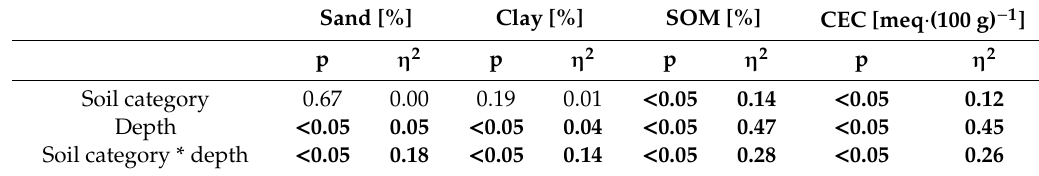
Table 6. Significance (p) and e ff ect size ( η 2 ), testing depth- and soil-related influence on soil parameters (Two-way ANOVA for soil categories FOR, CUT, SUC and REF). Significant values appear bold. Sand [%] Clay [%] SOM [%] CEC [meq · (100 g) − 1 ] p η 2 p η 2 p η 2 p η 2 Soil category 0.52 < 0.05 < 0.05